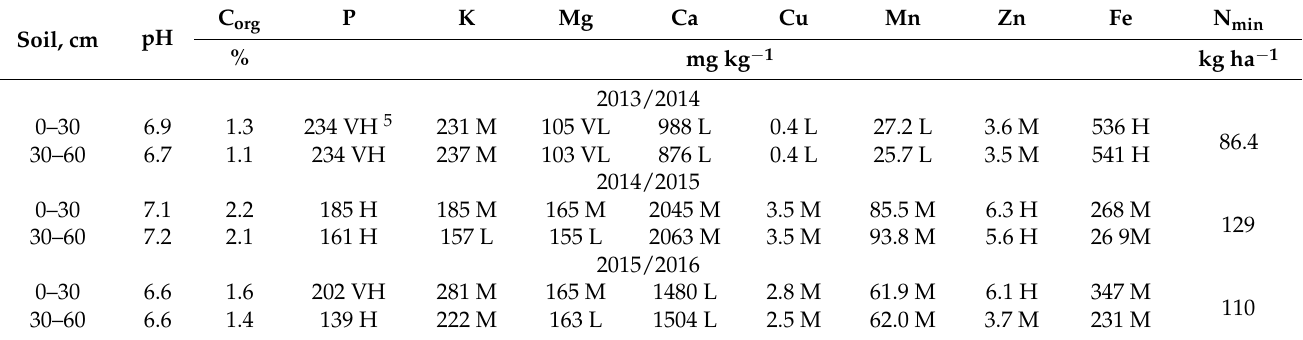
Table 1. Soil agrochemical characteristics in consecutive growing seasons 1,2,3,4